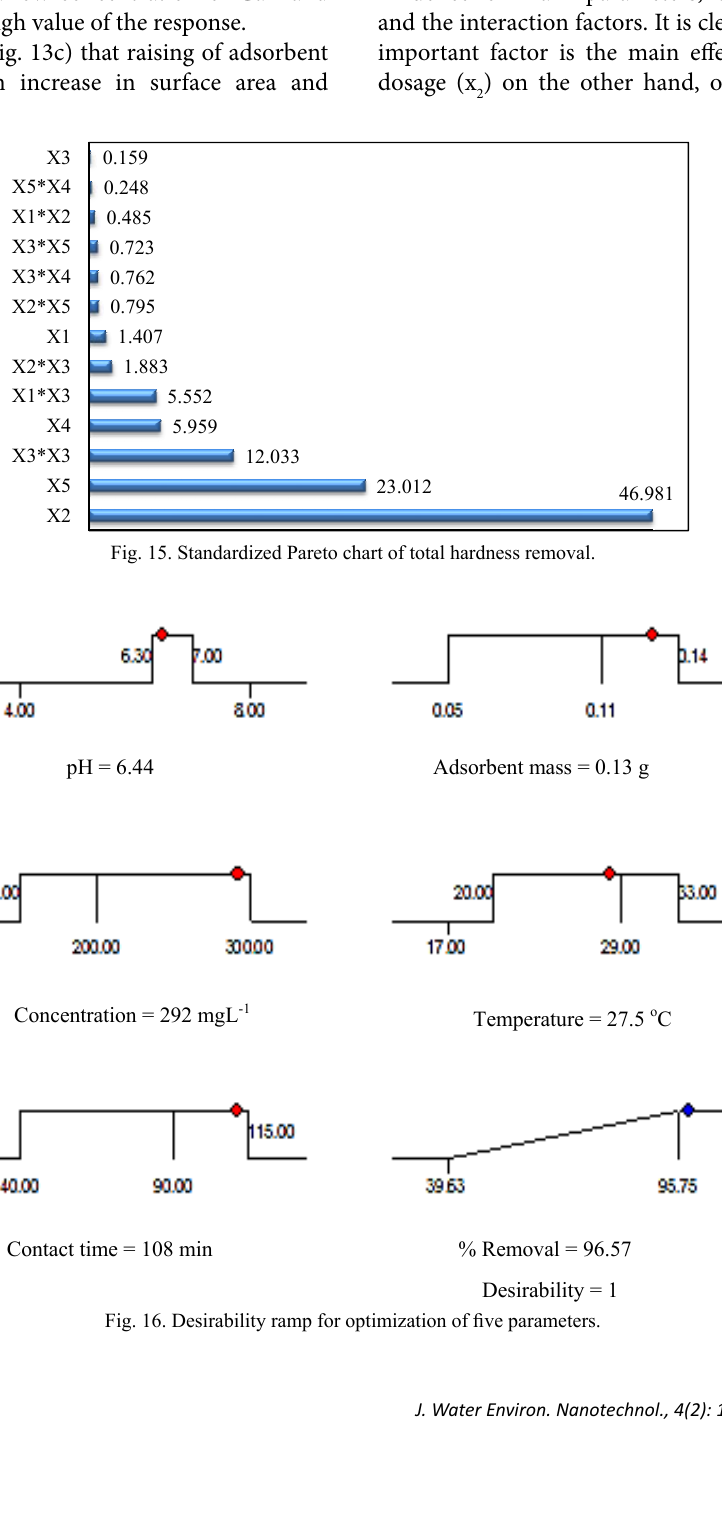
Fig. 16. Desirability ramp for optimization of five factors